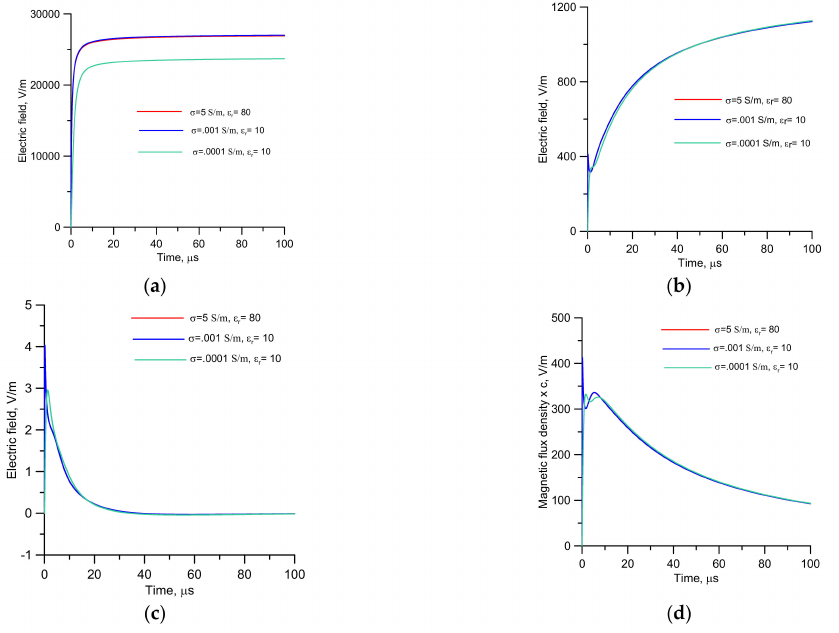
Figure 11. The source electric and magnetic fields generated by a subsequent return stroke for three sets of electric parameters at the strike point when including the current reflection at ground level.